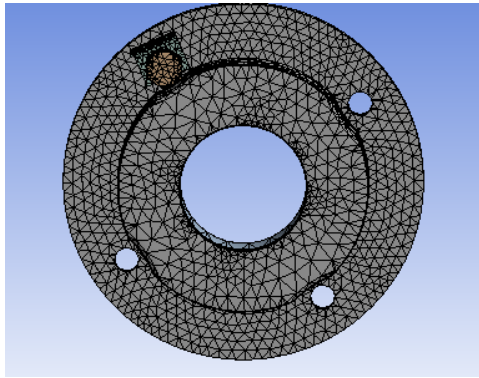
Figure 4. The meshed system.